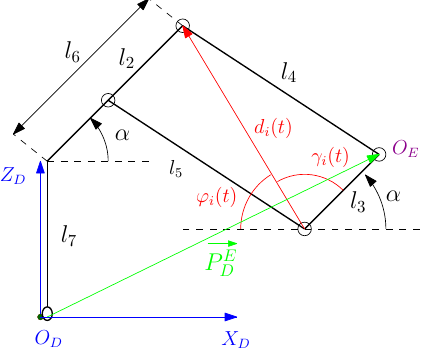
Figure 4. Scheme of the mechanism of the